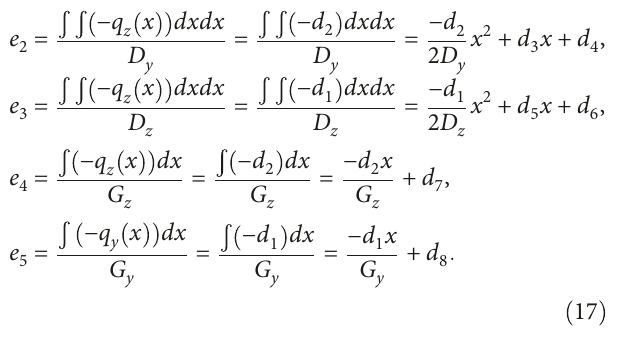
Figure 5: Loading case and the distributions of NDI identi fi cation points.